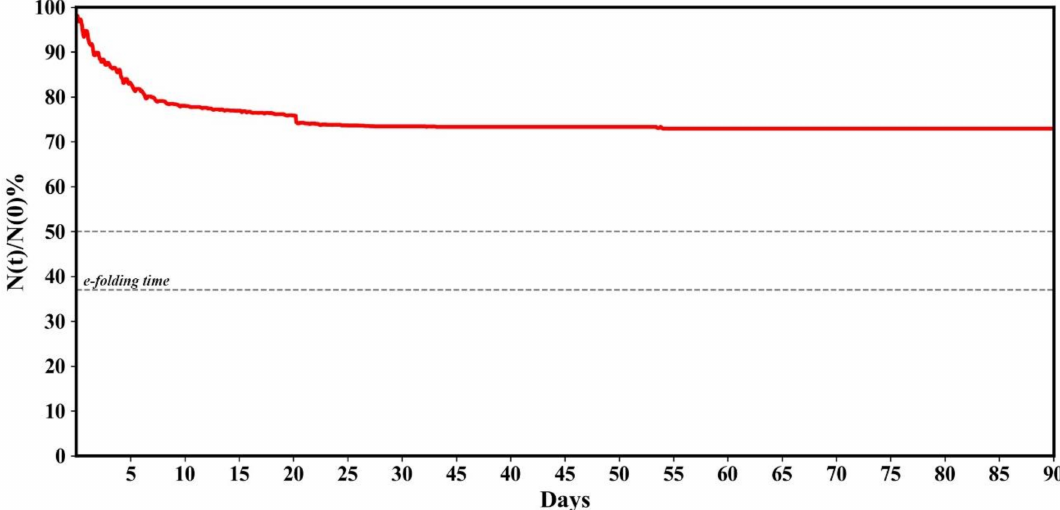
Figure 14. The residence time of CE during the pre-monsoon season was calculated with a resolution of 300 m. A total of 2584 particles were realised over the model domain. N (0) is the initial number of particles in the domain and N (t) is the number of particles at time t . Fast and slow flushing phases were not experienced in the pre-monsoon